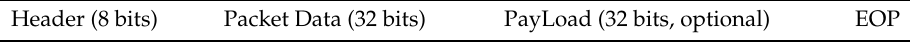
Table 2. SpiNNaker data packet structure.